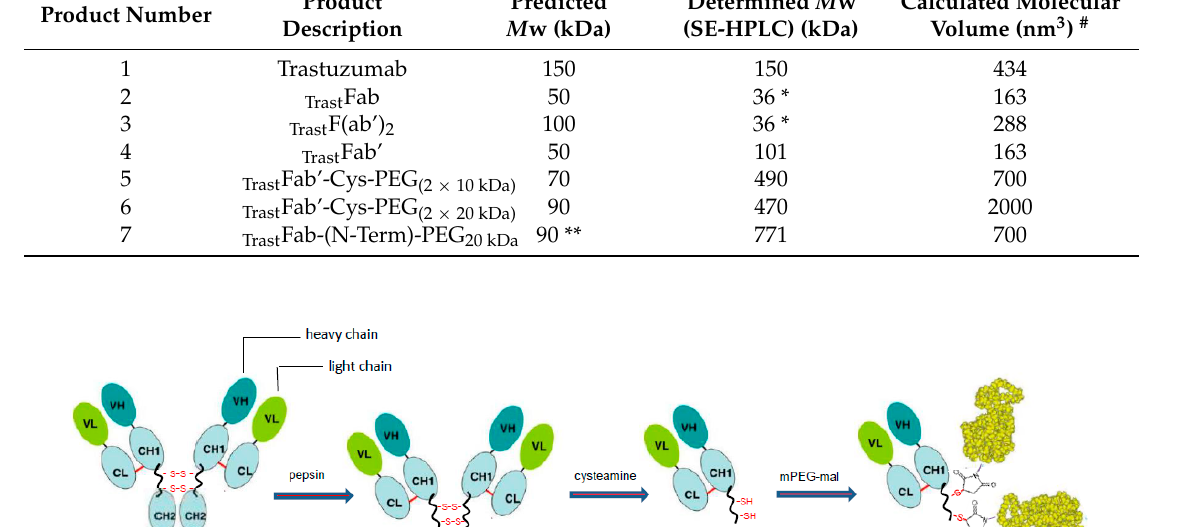
Table 1. List of Trastuzumab derivatives used in this study. Table shows the predicted molecular weight ( M w) of the molecules along with their corresponding M w as determined by SE-HPLC. * The Fab M w is seen as 36 kDa in our experimental conditions; ** The expected M w of product number 7 is predicted to be 90 kDa if PEG is attached on the N-terminus of both light and heavy chain; # Molecular volumes have been roughly calculated using the equation reported by Fee and Alstine [16] and using the a and b constants of albumin. Equation used: R h,PEGprot = 0.82(M r,prot ) 0.33 + a + bM r,PEGtot . R h,PEGprot : hydrodynamic radius of the PEGylated protein in Angstrom; M r,prot : M w of the protein in Da; M r,PEGtot : M w of the PEG in Da.